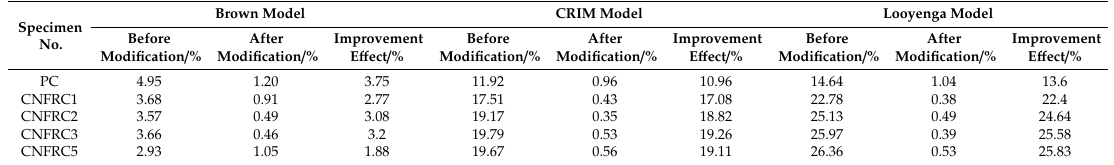
Table 5. Average error for ε , of models before and after modification.